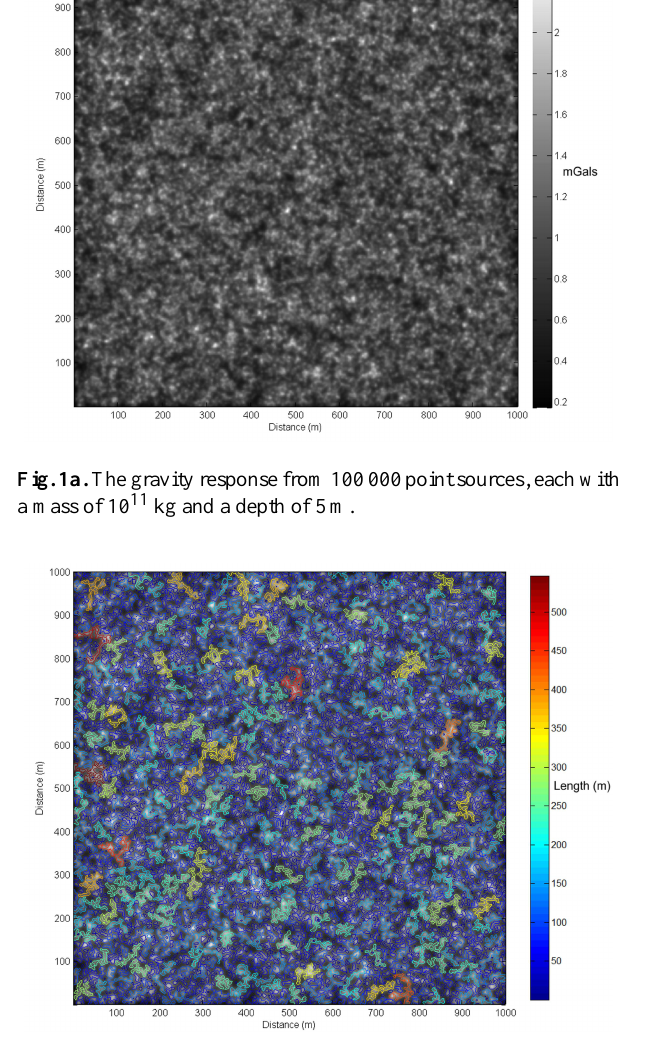
Fig. 1b. Edge contours of the data shown in Fig. 1a. The contours are coloured according to their length.